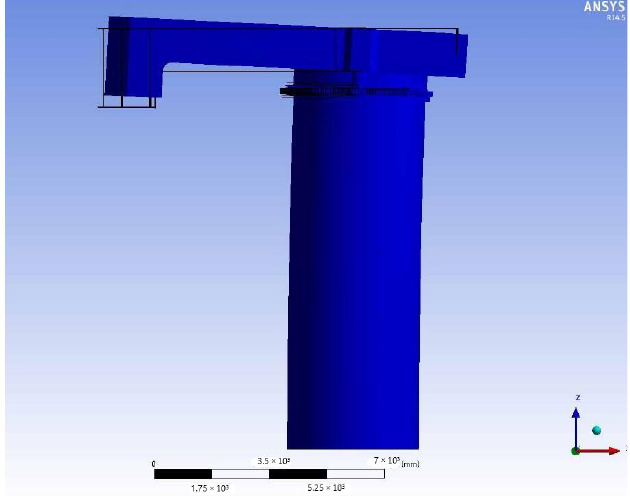
Figure 12. Overall deformation of the assembled body model after loading.